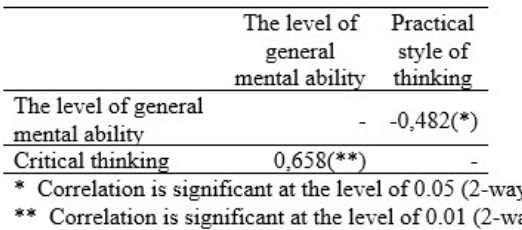
Table 5. Correlation analysis of the style characteristics of students not involved in eS-